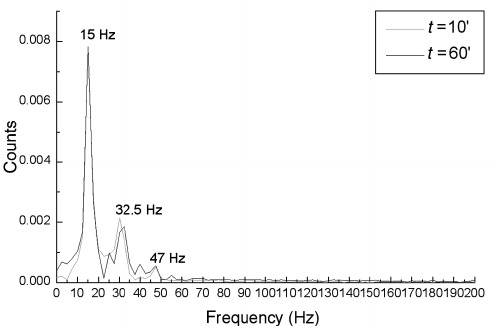
Fig. 2. Fourier analysis of mill impact frequencies ad different grinding times.